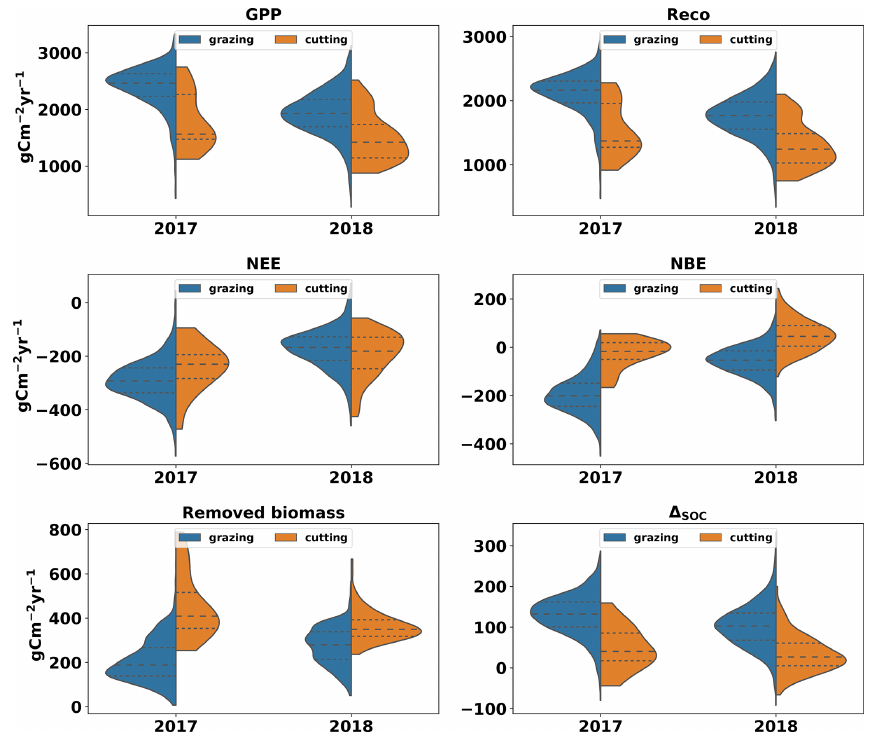
Figure 5. Violin plots of GPP, Reco, removed biomass and C flux from litter to SOC based on MDF predictions (2017–2018) for all simulated fields. Violin plots are split according to whether grazing or cutting removed most grass biomass. The blue side of each violin plot shows results for fields in which most biomass was removed via grazing (GCD > 0). The orange side shows results for fields in which most biomass was removed via cutting (GCD < 0).